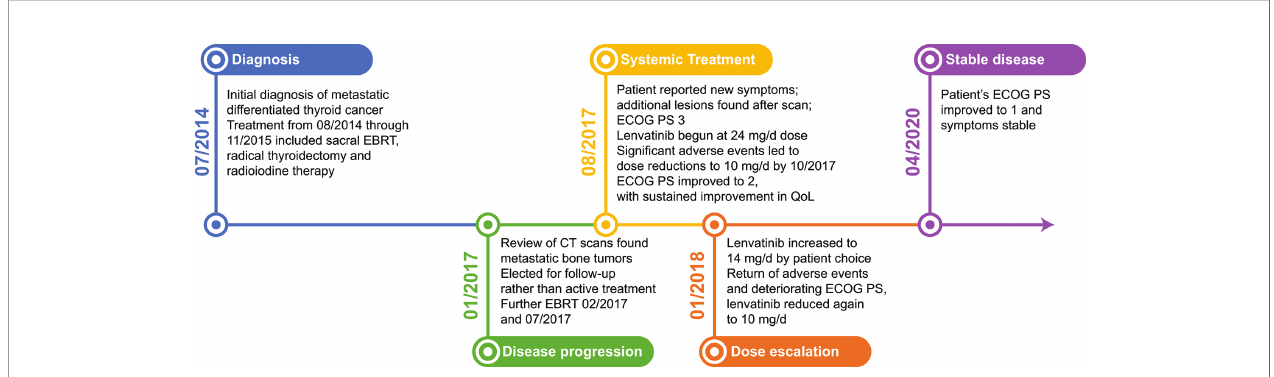
FIGURE 1 | Case Report Timeline: Patient was initially diagnosed in July 2014, and received EBRT, a radical thyroidectomy, and radioiodine therapy. Metastatic bone tumors were found in January 2017 and the patient received additional EBRT. Seven months later the patient reported decreased quality of life and new symptoms and began systemic treatment with lenvatinib. Adverse events and dose modi fi cations were managed cooperatively between the local treatment team and the specialist oncologist. As of April 2020, the patient remained stable, with an ECOG PS of 1. CT, computed tomography; EBRT, external beam radiotherapy; ECOG PS, Eastern Cooperative Oncology Group performance status; QoL, quality of